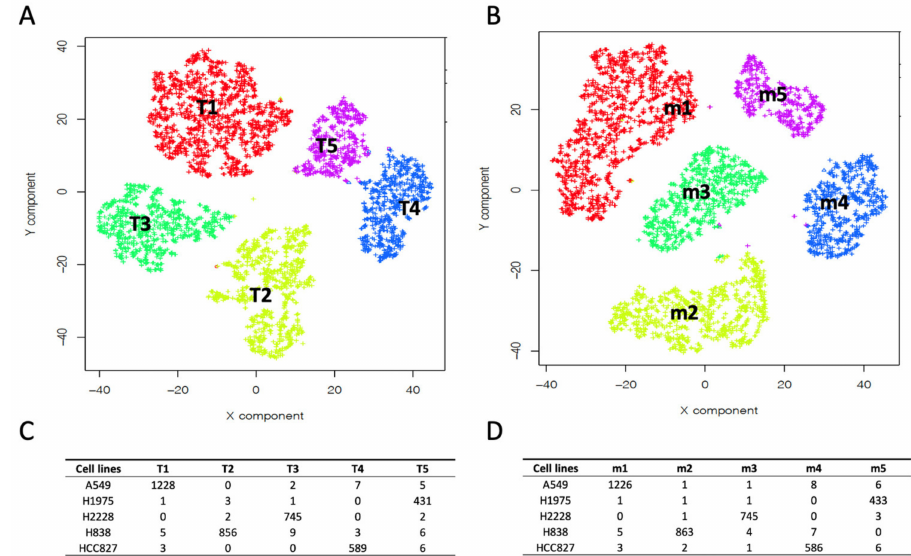
Figure 5. Clustering of cells in RNA-5c using SCA meta-genes. ( A ) Results of the clustering of SCA meta-genes based on TFs, ( B ) Results of the clustering of SCA meta-genes based on miRNA, ( C ) Summary of the cells, in the various clusters based on TFs, associated with the cell lines present in RNA-5c experiment. ( D ) Summary of the cells, in the various clusters based on miRNAs, associated with the cell lines present in the RNA-5c